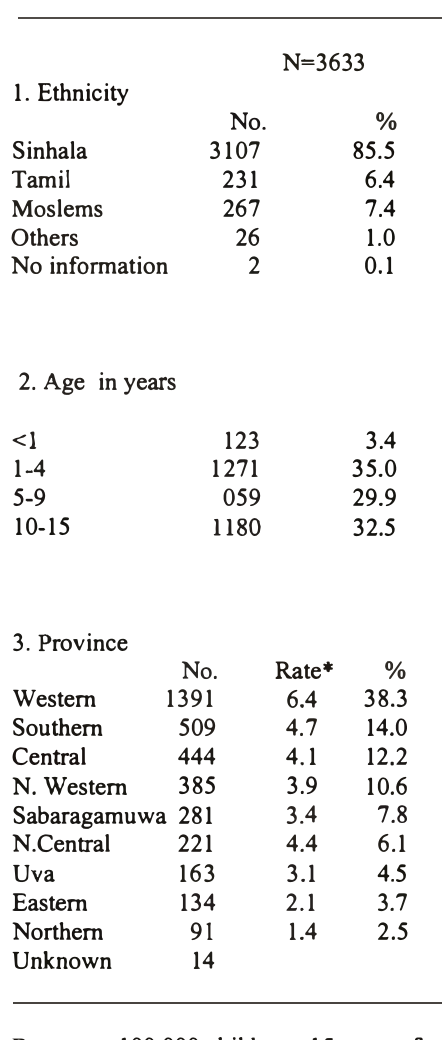
Table 1: Summary table showing